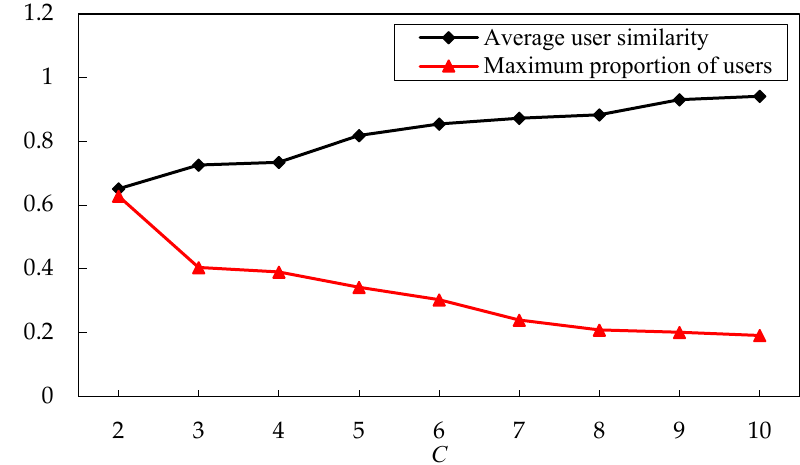
Figure 8. Maximum proportion of users and average user similarity. Table 4. User cluster information ( C = 7).